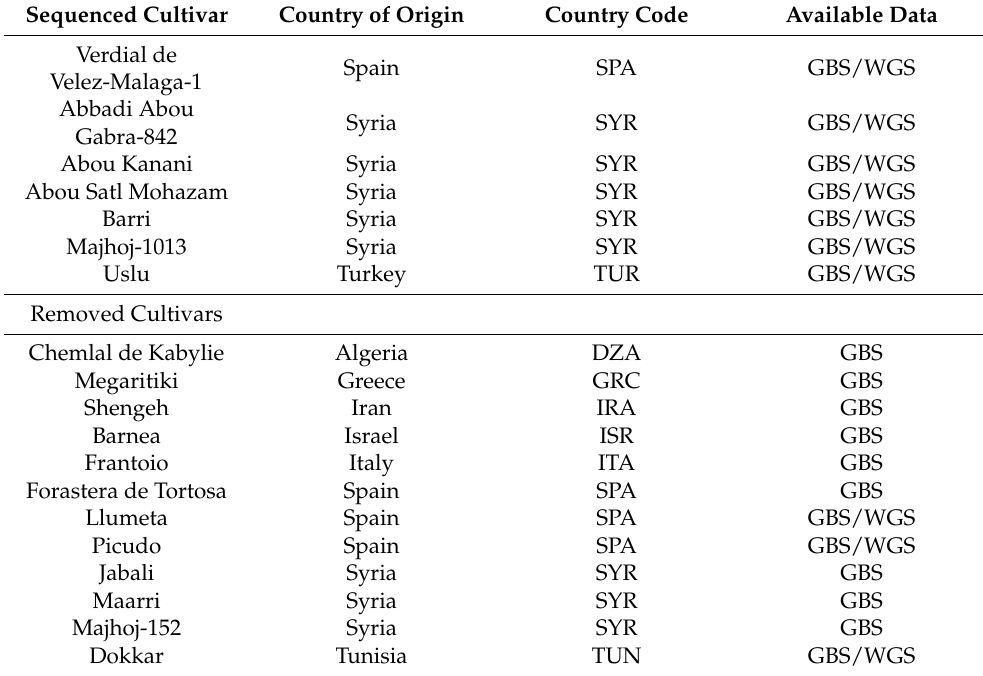
Table 1. Cont. Sequenced Cultivar Country of Origin Country Code Available